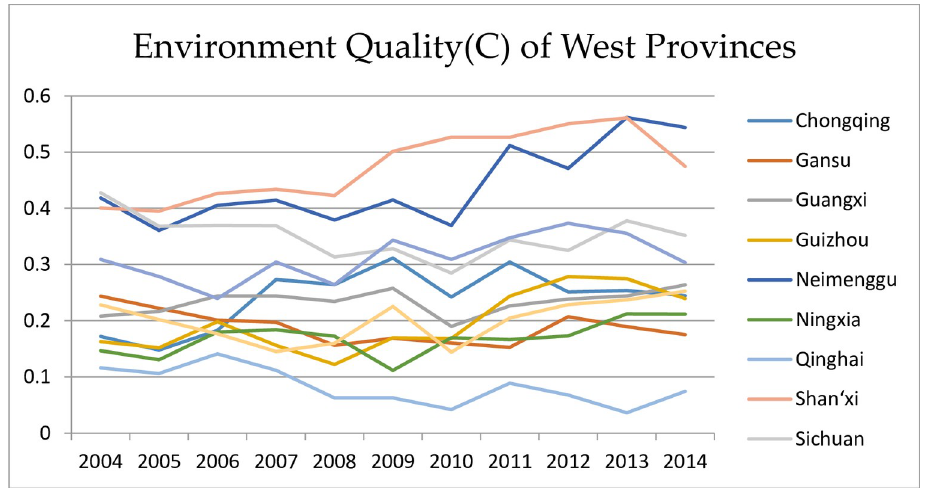
Fig 2. Environment quality (C) of West Region.